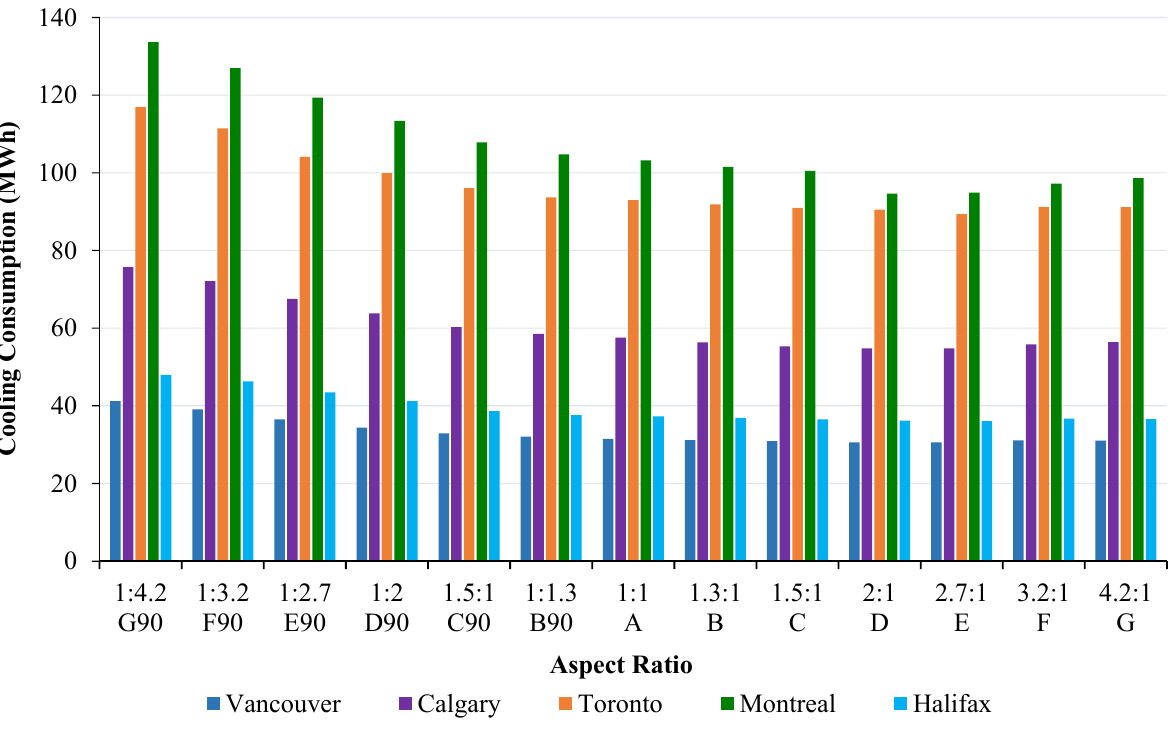
Figure 14. Annual cooling consumption for aspect ratios in Canadian cities.